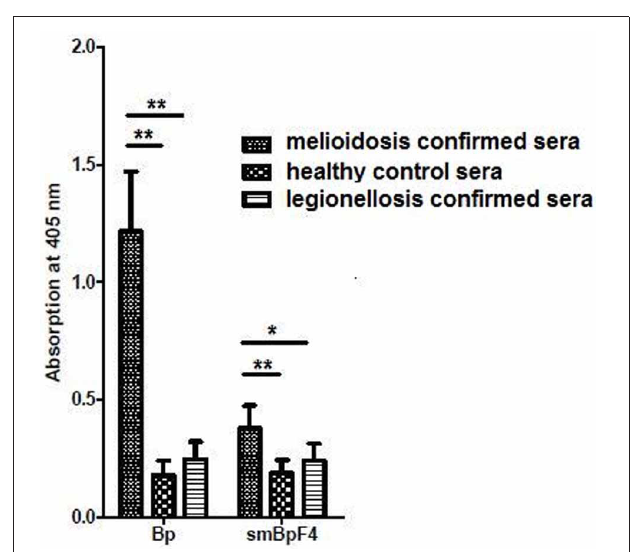
FIGURE 2 | Recombinant MprA protease, smBpF4, is sero-reactive. Reactivity of purified smBpF4 and B. pseudomallei lysate (Bp) with pooled melioidosis-confirmed, healthy control and legionellosis-confirmed sera. Significance was determined by Student’s t -test ( ∗ P < 0 . 05; ∗∗ P < 0 . 01).